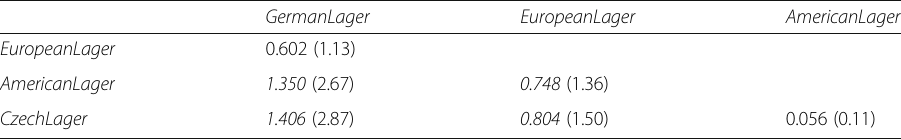
Table 4 Lager price difference